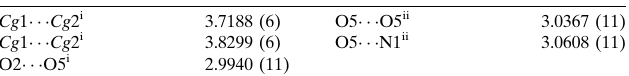
Selected interatomic and centroid–centroid distances (A˚ ). Cg 1 and Cg 2 are the centroids of the C1–C5/C10 and C5–C10 rings, respectively.